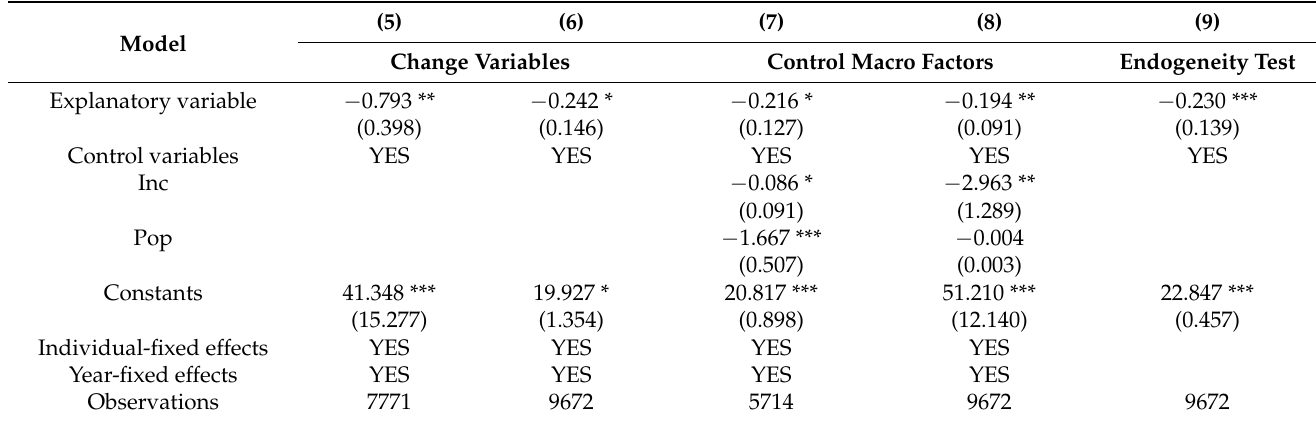
Table 3. Robustness test